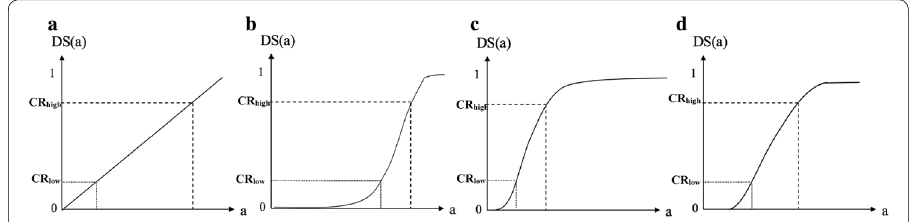
Fig. 3 Characteristic cumulative demand for given critical ratios. Figure 3 shows characteristic cumulative demand for a uniform, b high, c low, and d medium future expected demand of skills (with a: level of skills inventory, and ds(a): distribution function of demand for specific level of skilled workers, CRH: UC > OC